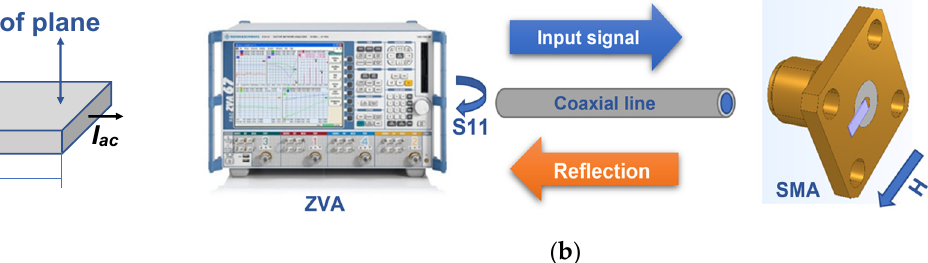
Figure 1. ( a ) Schematic description of amorphous ribbon sample with dimensions l × d × h: H is the external magnetic field applied during magnetic and GMI measurements, however for FMR measurements in the resonance cavity both in-plane and out-of-plane orientations of the external magnetic field were used; EMA 1 corresponds to the easy magnetization axis of the sample in initial state; EMA 2 corresponds to the easy magnetization axis of the sample after relaxation annealing; and EMA 3 corresponds to the easy magnetization axis of the sample after TMO. ( b ) The scheme of the broadband microwave measurements using ZVA VNA for the coaxial position of a sample; H is an external magnetic field.